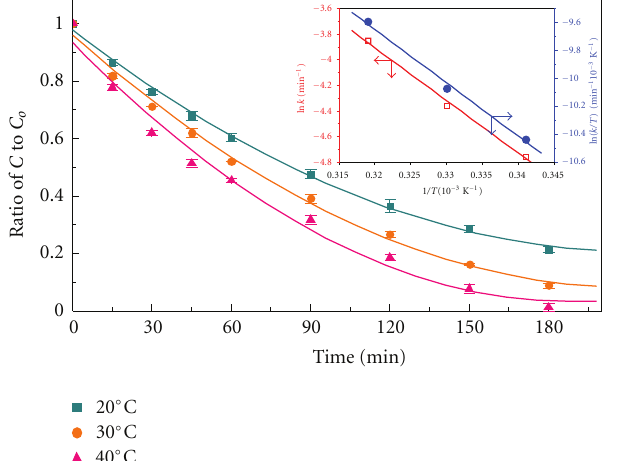
Figure 6: The air feeding dependence of nitrobenzene photode- graded by TiO 2 as time changes. The processes were operated with 0.2g TiO 2 and 0.407 mM nitrobenzene at pH 7 and 30 ◦ C for 3 h. Inset shows the relationships between the air feeding and rate constant, NB residue,